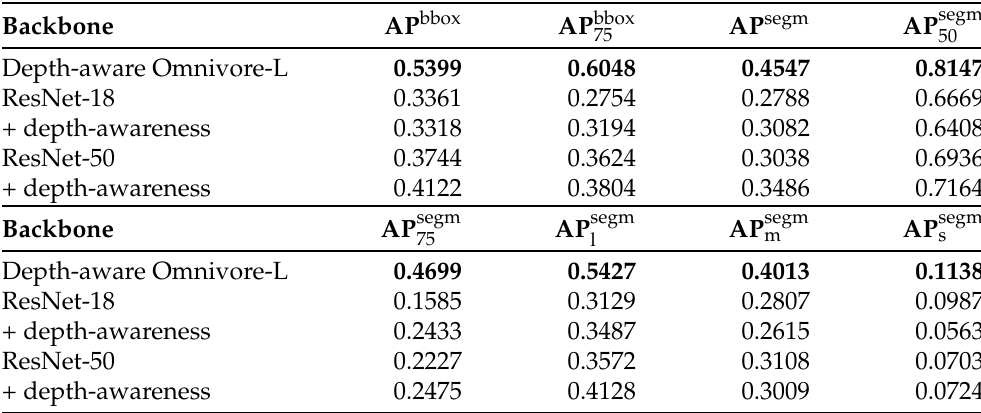
Table A1. COCO metrics on the Plittersdorf instance segmentation dataset task using Cascade Mask R-CNN with depth-aware Omnivore-L and ResNet backbones, evaluated using 10-fold cross-validation. The respective best value for each metric is highlighted in bold.